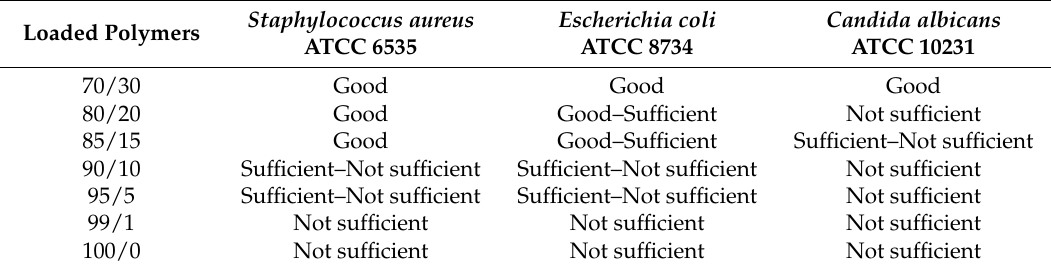
Table 1. Antimicrobial activity of loaded polymers against Staphylococcus aureus ATCC 6535, Escherichia coli ATCC 8734 and Candida albicans ATCC 10231.